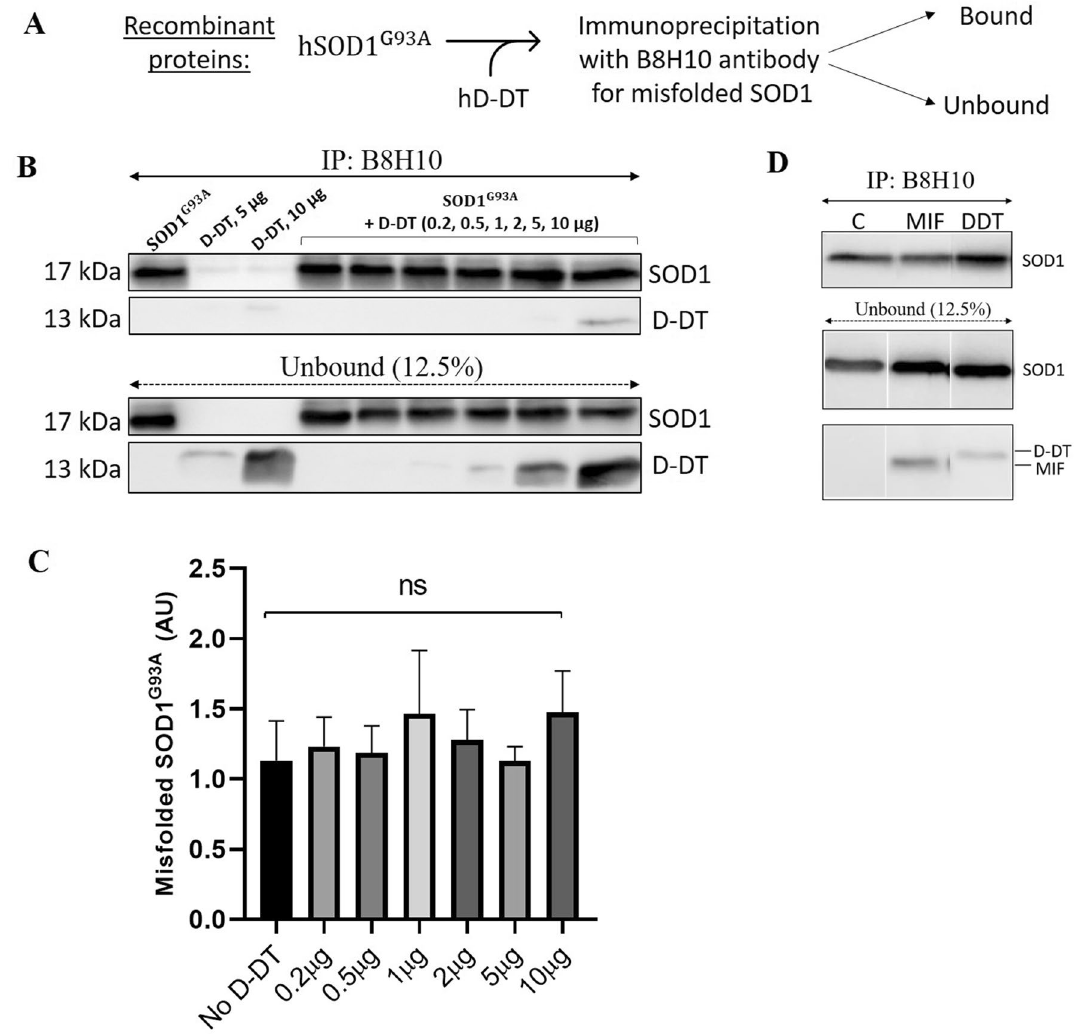
Figure 2. Recombinant D-DT does not affect mutant SOD1 misfolding. ( A ) Schematic representation of the experimental protocol using recombinant purified proteins. ( B ) The accumulation of misfolded SOD1 was determined by immunoprecipitation with B8H10 antibody, which recognizes misfolded SOD1, after incubating recombinant SOD1 G93A (2 µg) with increasing concentrations of recombinant D-DT (0.2, 0.5, 1, 2, 5, and 10 µg). Immunoblotting was used to determine the levels of SOD1 and D-DT present in the bound and unbound fraction of each immunoprecipitation assay. Data indicate one membrane out of 3 independent experiments. Full-length gels are presented in Supplementary Figure S4. ( C ) Quantification of immunoblotting bands with Evolution-Capt Edge software. Quantification analysis of the relative misfolded SOD1 (Bound/Unbound) performed with one-way ANOVA (n = 3). Bars represent mean ± SEM. ( D ) The accumulation of misfolded SOD1 was determined by immunoprecipitation with B8H10 antibody after incubating mutant SOD1 (2 µg) with recombinant MIF or D-DT (1 µg). Data indicate one representative experiment out of 3 independent experiments. The lanes from the right panel were not loaded in the same order as state, strongly co-precipitates with mutant SOD1, in contrast to MIF WT41 . To investigate whether recombinant D-DT interacts with mutant SOD1 and reduces misfolded SOD1 G93A accumulation, similarly to MIF, we per- formed immunoprecipitation with B8H10 antibody, which recognizes various forms of misfolded SOD1. We incubated purified mutant SOD1 G93A alone, or in the presence of recombinant human D-DT in a dose-depend- ent manner (Fig. 2A). Moreover, we incubated recombinant D-DT alone, serving as a control for the specificity of B8H10 binding to the misfolded SOD1. Although D-DT co-precipitated with mutant SOD1 G93A , as seen in the bound fraction for the higher concentrations only, using anti-D-DT antibody, it did not inhibit misfolded SOD1 accumulation, as recognized by immunoprecipitation with B8H10 antibody (Fig. 2B). Quantification analysis showed a non-significant difference in all the concentrations tested (Fig. 2C). In contrast to D-DT, recombinant MIF (1 µg) reduced mutant SOD1 misfolding at a lower dose (Fig. 2D).